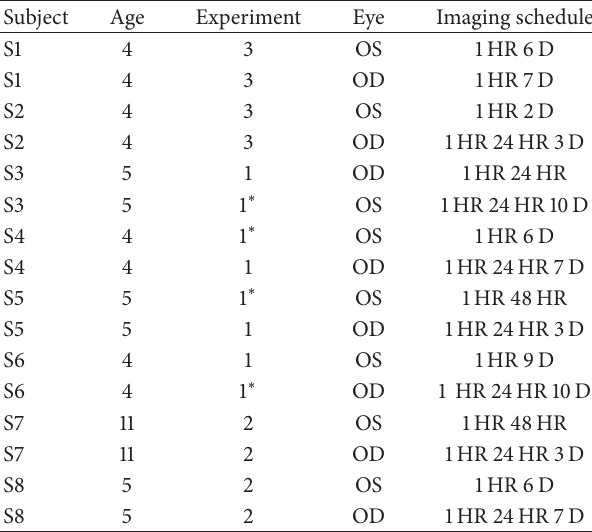
Table 2: Summary of imaging schedule for experiments 1–3.